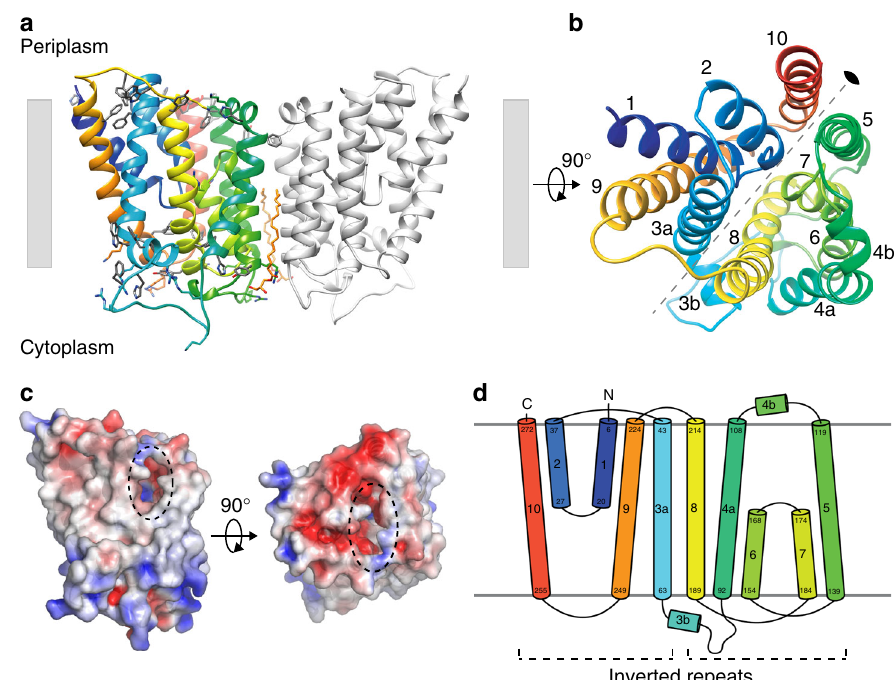
Fig. 1 The crystal structure of Ec UppP at 2.0 Å resolution. a Cartoon representation of Ec UppP dimer with one monomer-colored rainbow from the N- (blue) to C-terminal (red). Aromatic and positively charged residues at the membrane interface shown as stick and highlight orientation with respect to the inner membrane (shown as gray bars). Two monoolein lipids at the dimer interface shown as stick. b Ninety-degree rotation from a viewed from periplasm. Colored as a and helices numbered. Twofold pseudosymmetry axis parallel to the plane of the membrane shown as gray dotted line. c Electrostatic surface potential of UppP monomer. Orientations as in a and b , respectively. Dotted circles indicate location of periplasmic substrate-binding cleft. d Secondary structure topology highlighting interlocked inverted